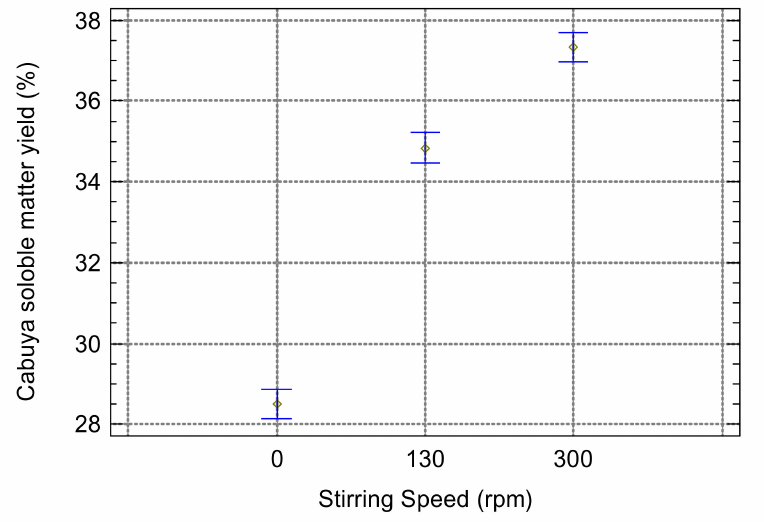
Figure A2. Results of Fisher’s LSD test ( P < 0.05) for cabuya soluble matter yield as a function of extraction stirring